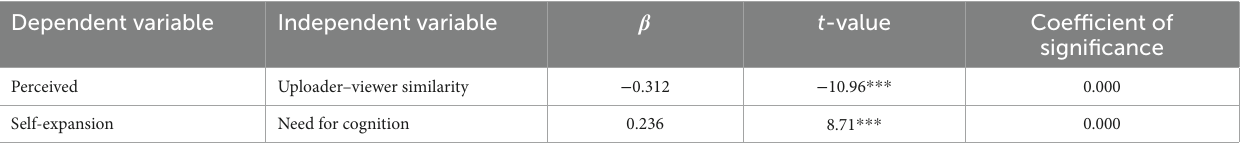
TABLE 6 The moderating effect analysis.